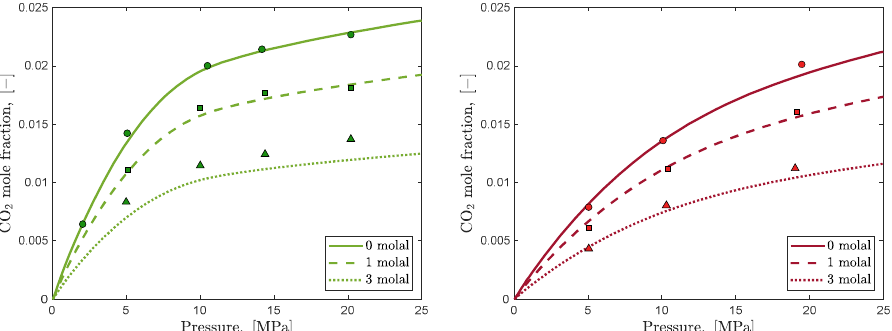
Figure 6. Solubility of CO 2 in 0, 1, and 3 molal brine at 50 °C (left) and 100 °C (right) as a function of pressure. The discrete points are experimental data presented in [53], and the continuous lines are calculated by the simulator.